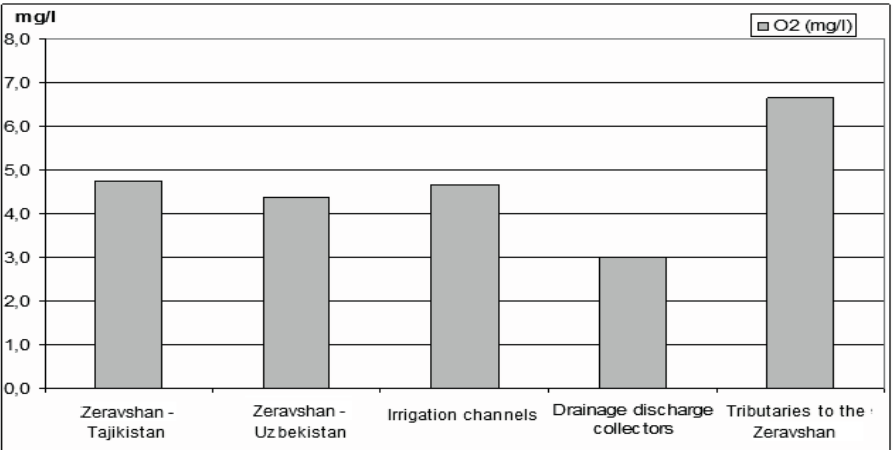
Fig. 3 Content of oxygen of Zeravshan River in Tajikistan and Uzbekistan territories, irrigation channels and drainage collectors in Uzbekistan and tributaries of Zeravshan